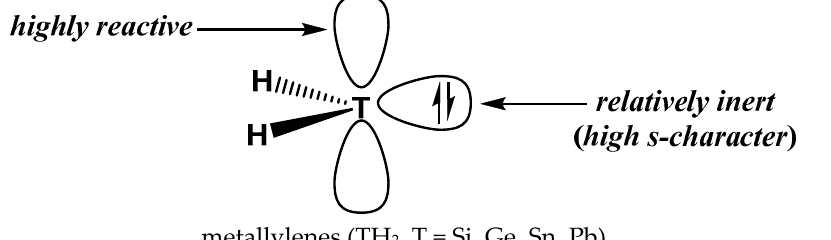
Figure 1. Ground-state structures of methylene and metallylenes.